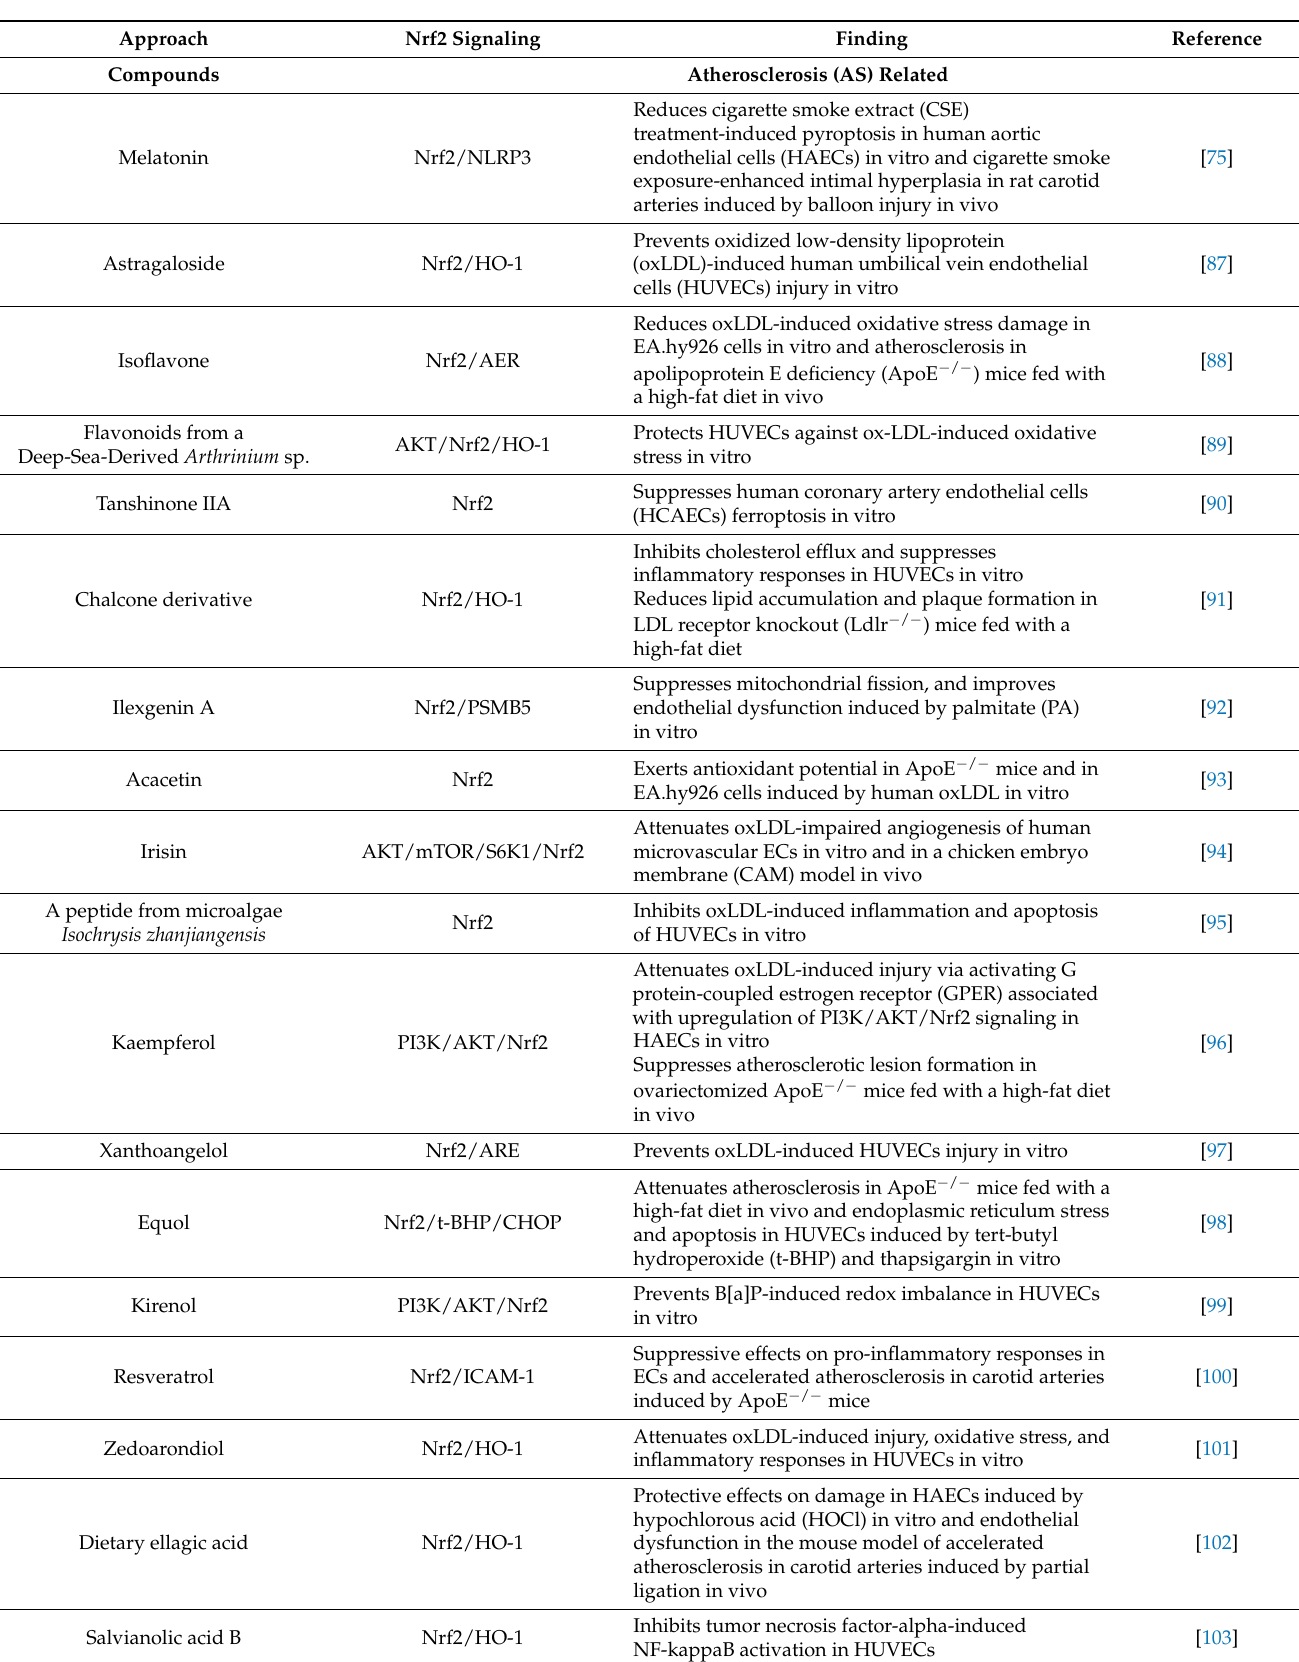
Table 1. Therapeutic targeting Nrf2 signaling for EC